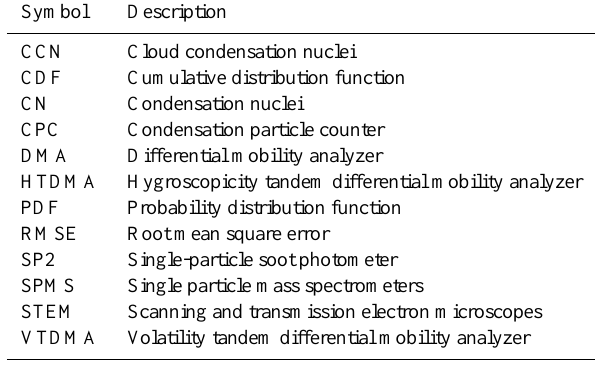
Table 3. Acronyms